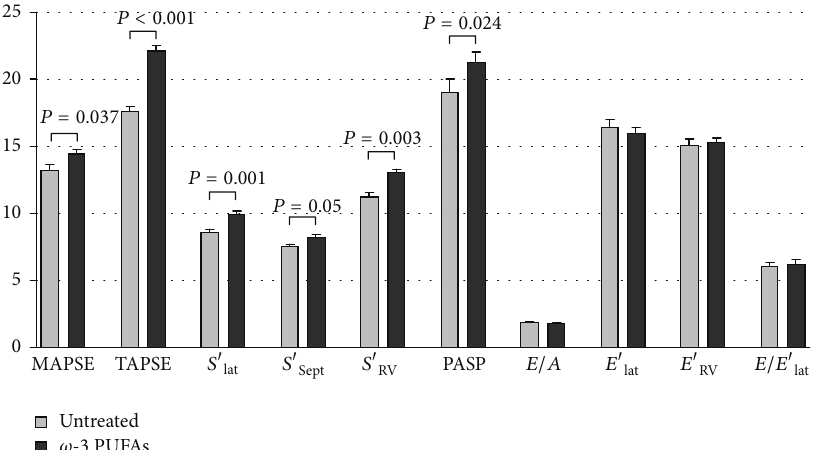
Figure 1: Dietary 𝜔 -3 PUFAs supplementation for 12 months significantly improves biventricular systolic longitudinal parameters in girls : peak with typical Rett syndrome. MAPSE: mitral annular plane systolic excursion; TAPSE: tricuspid annular plane systolic excursion; 𝑆 󸀠 lat : peak systolic velocity of septal mitral annulus; 𝑆 󸀠 : peak systolic velocity of tricuspid annulus systolic velocity of lateral mitral annulus; 𝑆 󸀠 sep RV of right ventricle; PASP: pulmonary arterial systolic pressure; 𝐸/𝐴 : ratio between peak early diastolic mitral flow ( 𝐸 ) and peak late diastolic : peak early diastolic velocity of lateral mitral annulus; 𝐸 󸀠 : peak early diastolic velocity of tricuspid annulus of right mitral flow ( 𝐴 ); 𝐸 󸀠 lat RV : this ratio indirectly estimates left ventricle end-diastolic filling ventricle; 𝐸/𝐸 󸀠 lat